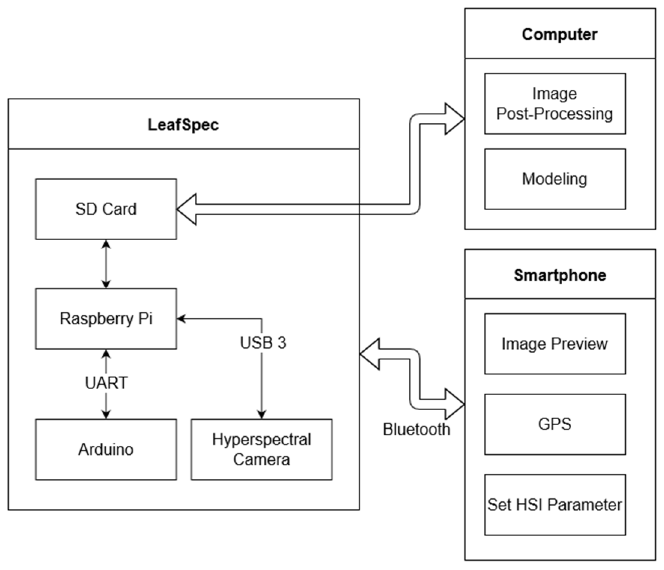
Figure 4. The data flow and management between the LeafSpec, smartphone, and computer. The LeafSpec device can be triggered to start scanning by using a push-button for manual operation or a relay for autonomous operation. The Raspberry Pi initializes the HSC and sends a command to the Arduino to close the LeafSpec device and start spinning the motor. The motor runs continuously until reaching the limit switch. After the motor has started spinning, the Raspberry Pi starts acquiring images until the HSC has reached the end of the scanning bed. During imaging, the Raspberry Pi requests the current distance from the Arduino and then stores the image in RAM for later processing. Once the scanning has been completed, the Arduino moves the HSC back to its original position. The Raspberry Pi processes the data by organizing the images into a single hypercube. The Raspberry Pi also generates an NDVI heatmap for showing as a preview on the smartphone. The user can then save or discard the data on the smartphone. The full HS images’ hypercube data are saved on the SD card installed on the Raspberry Pi for further processing the HS images and